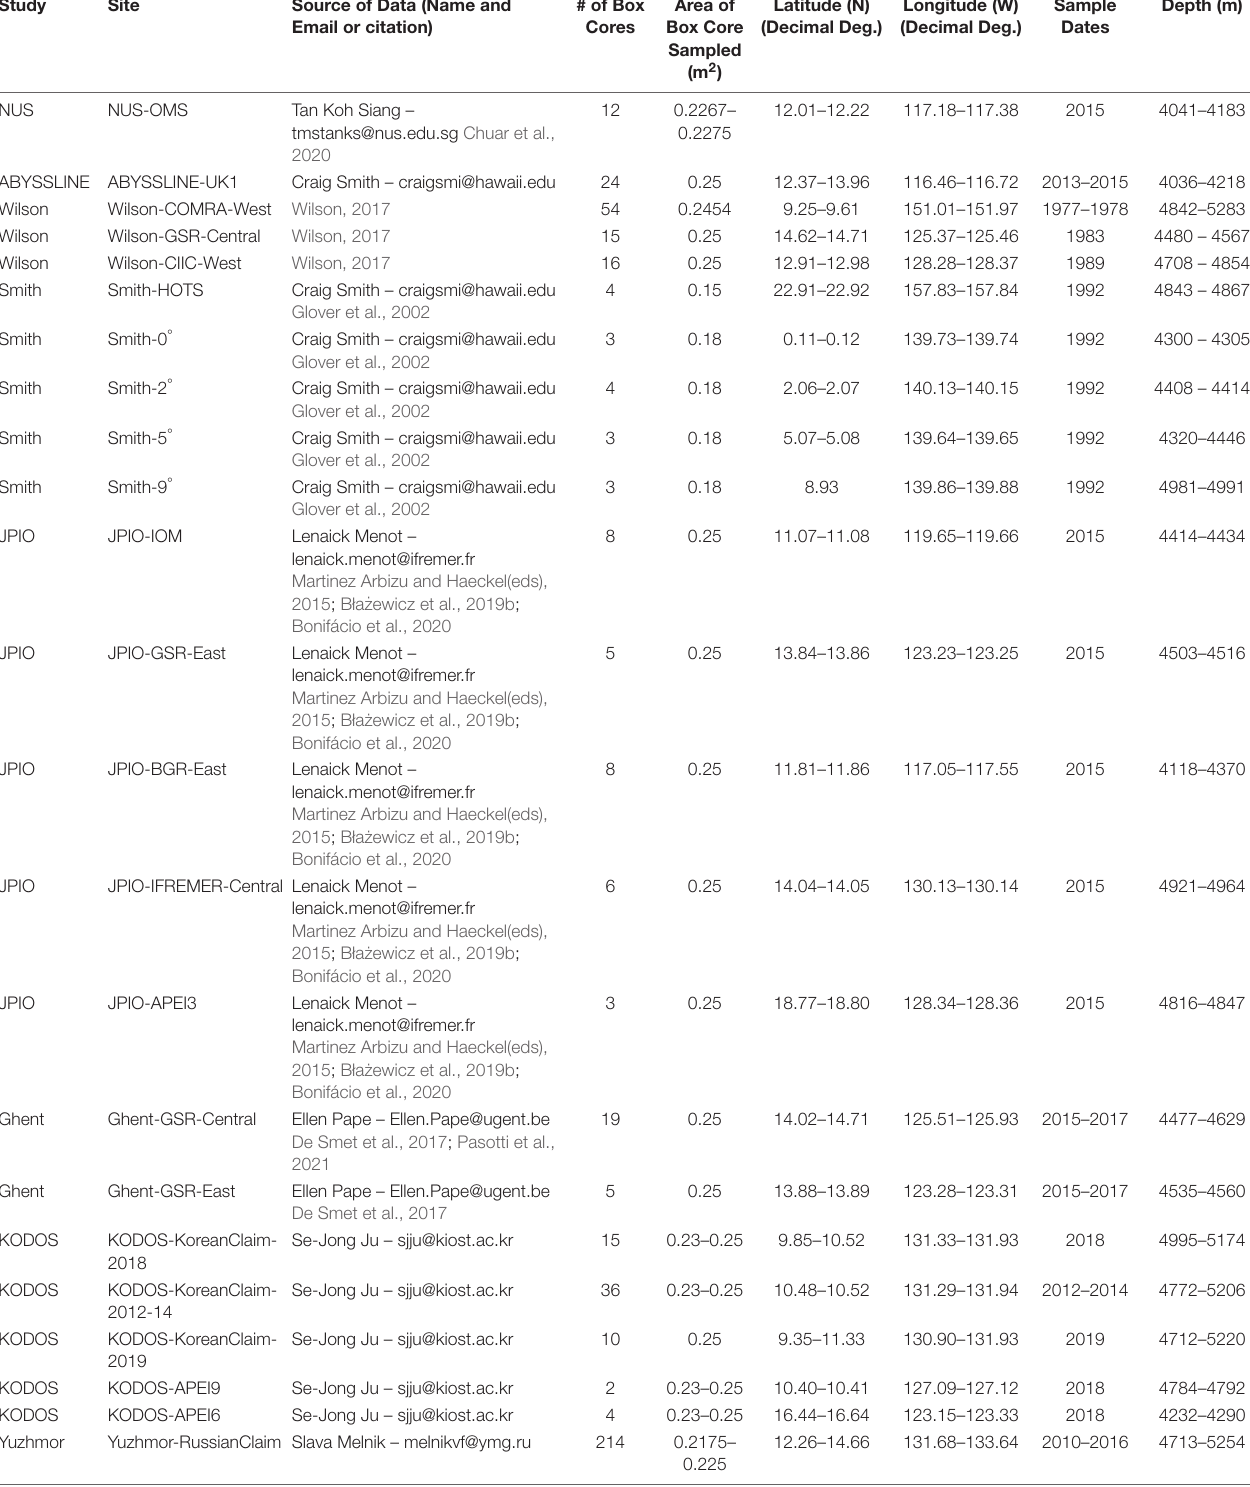
TABLE 1 | Sources, numbers (#) of box cores, locations, and depths for macrofaunal box-core data used in this